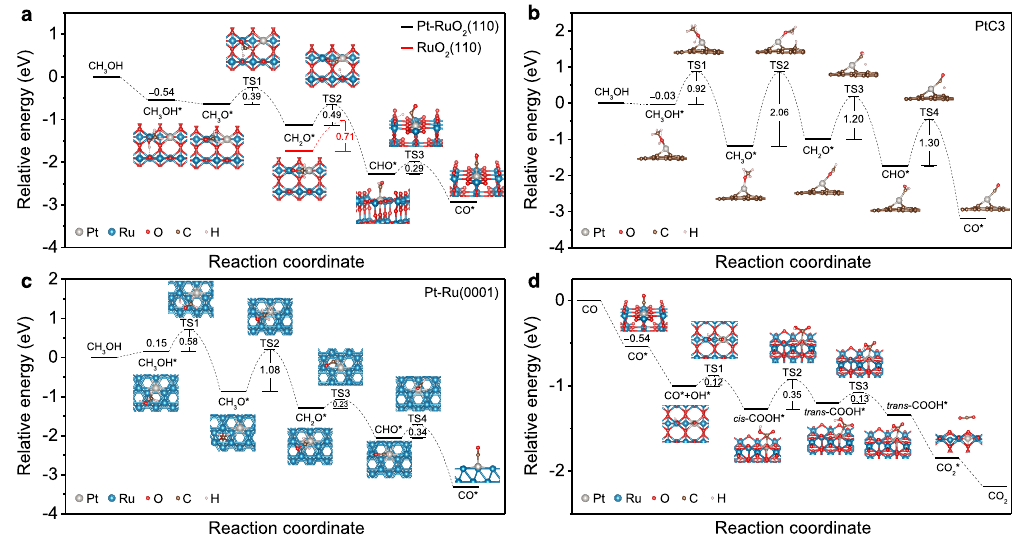
Fig. 6 MOR mechanism. a – c Calculated reaction free energy and energy barriers for methanol oxidation to CO at: a Pt-RuO 2 (110), b PtC3, and c Pt- Ru(0001). d Calculated reaction free energy and energy barriers for CO oxidation on Pt-RuO 2 (110). In ( a ), the relative energies of CH 2 O* and corresponding TS2 computed for RuO 2 (110) are shown for